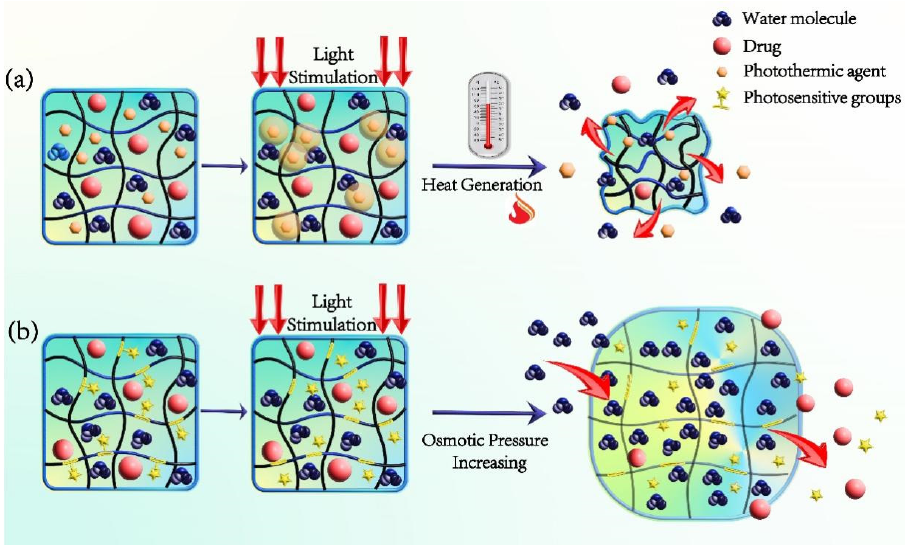
Figure 2. Drug release mechanism of the photosensitive hydrogel. ( a ) The photosensitive hydrogel containing photothermal agent; ( b ) Introducing photosensitive groups onto the chain of the gel polymer.